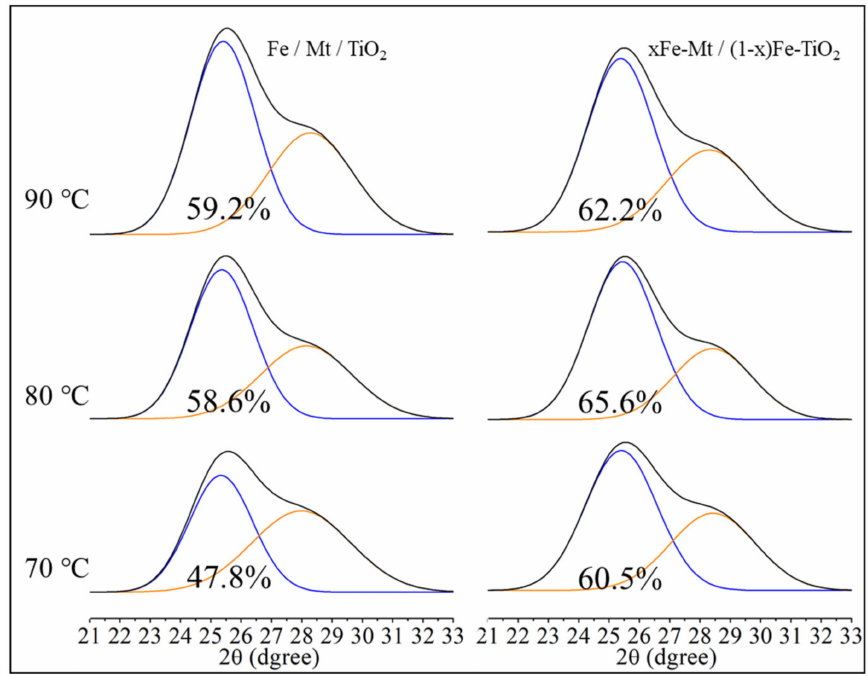
Figure 2. Peak fitting of the XRD patterns (20–35 ◦ in 2 θ ) of Fe/Mt/TiO 2 and x Fe-Mt/(1 − x )Fe-TiO 2 with different synthesis temperatures (70, 80, and 90 ◦ C). Peaks in blue were from anatase and peaks in yellow were from